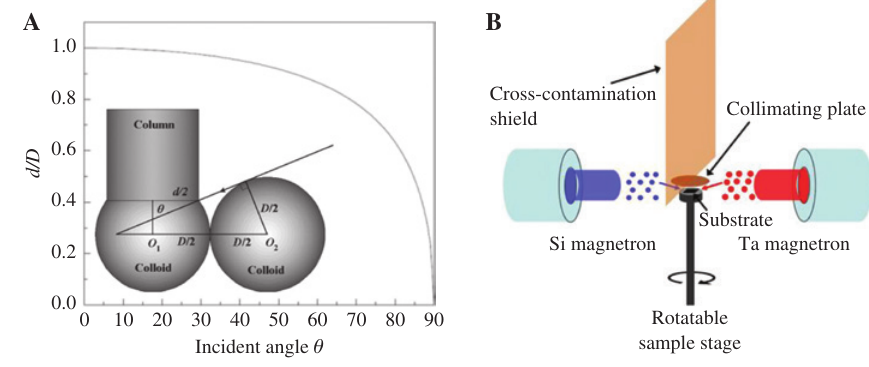
Figure 5: Schematic configuration of the geometrical model and opposite GLAD. (A) The ratio of column diameter d to the colloid particle diameter D as a function of incident flux angle θ [67]. The insert shows the geometrical relationship for these three parameters. (B) Chamber schematic for simultaneous opposite GLAD, from Ref.